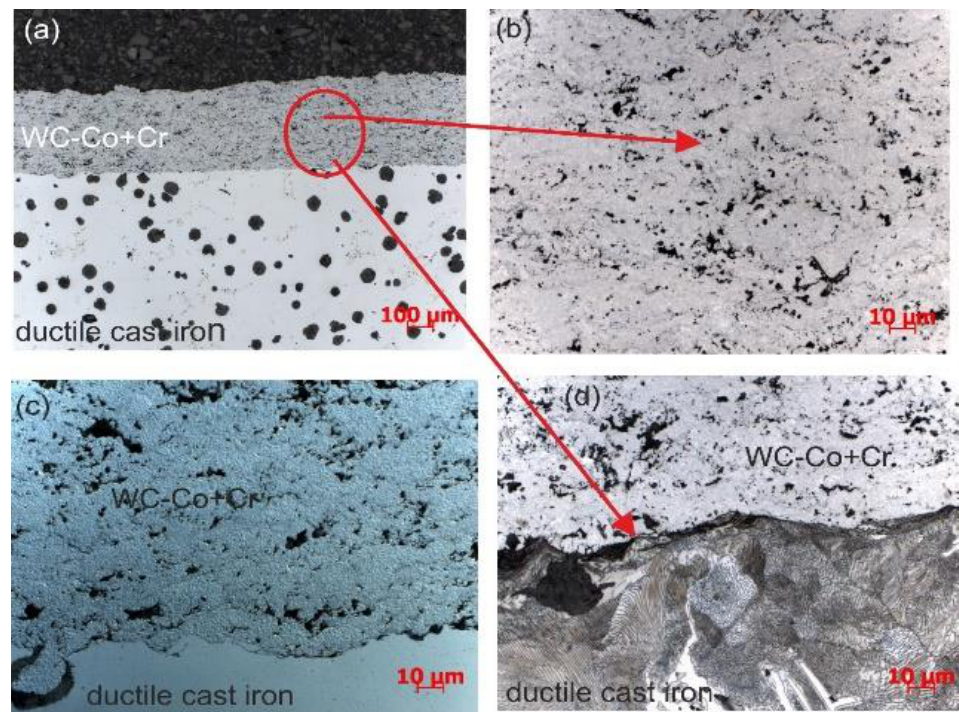
Figure 1. Microstructure of the composite coating (WC – Co + Cr) deposited on ductile cast iron: ( a ) LM image; ( b ) magnified area selected in Figure 1a; ( c ) details of the coating structure in differential interference contrast (DIC); ( d ) cast iron structure composed of ferrite and perlite.